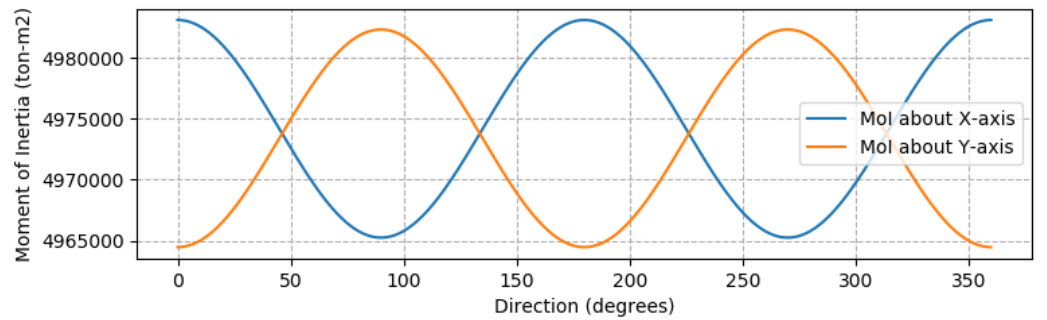
Figure 6. Total structural dynamic moment of inertia (MoI) with changing yaw direction.